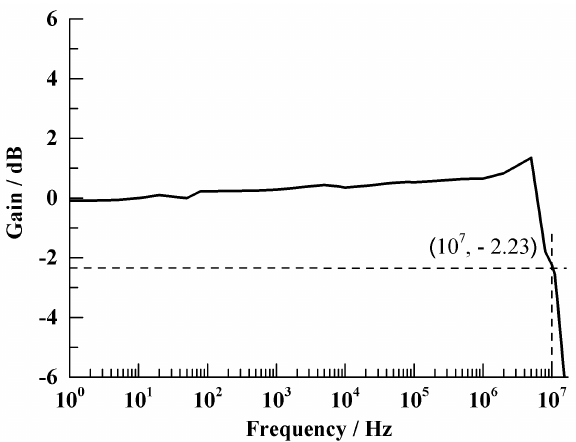
Figure 15. Amplitude – frequency characteristic curve of the divider.